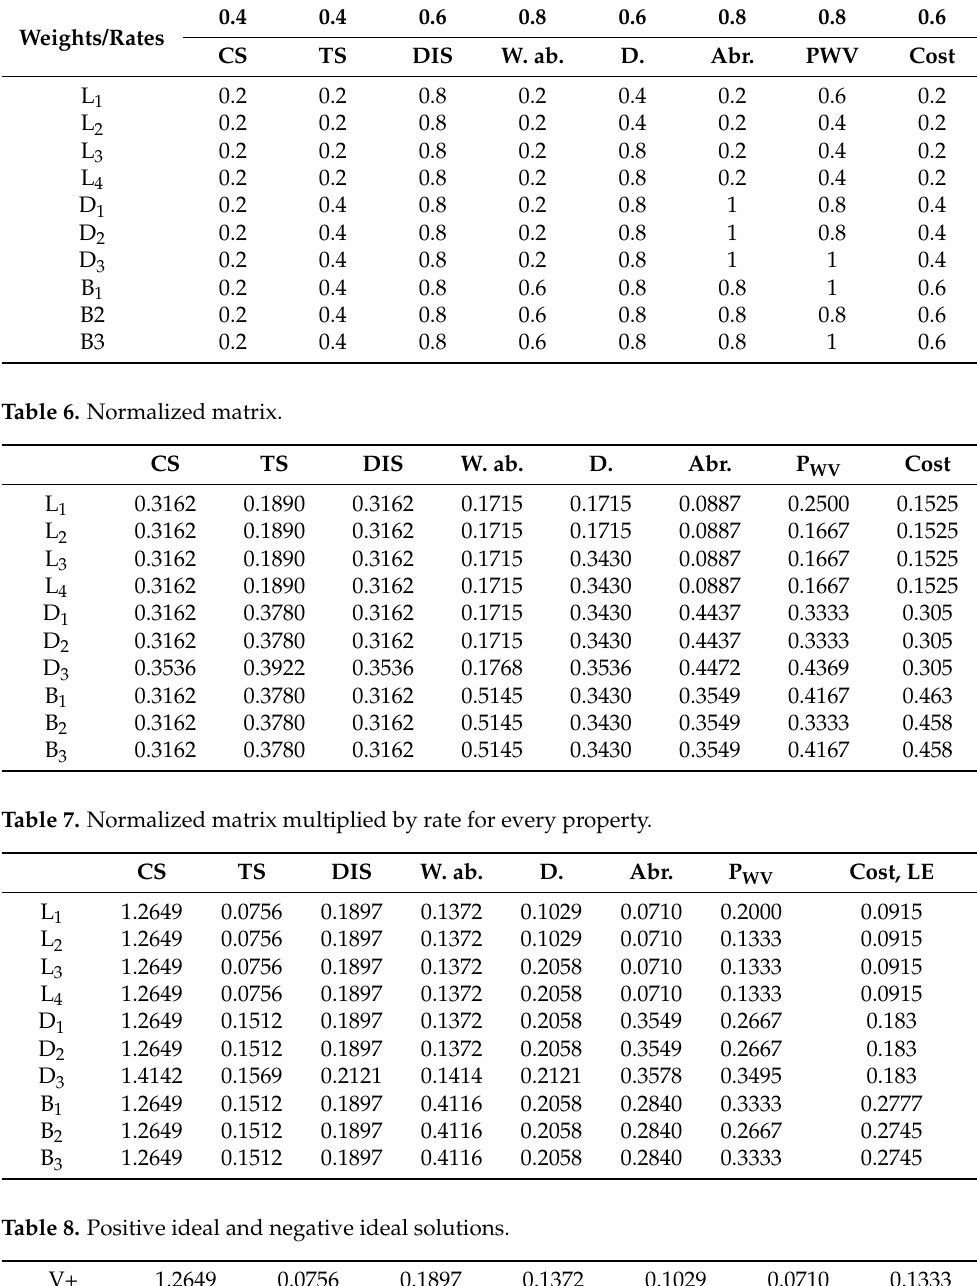
Table 5. Criteria for conversion to new approach based on weight and rate.